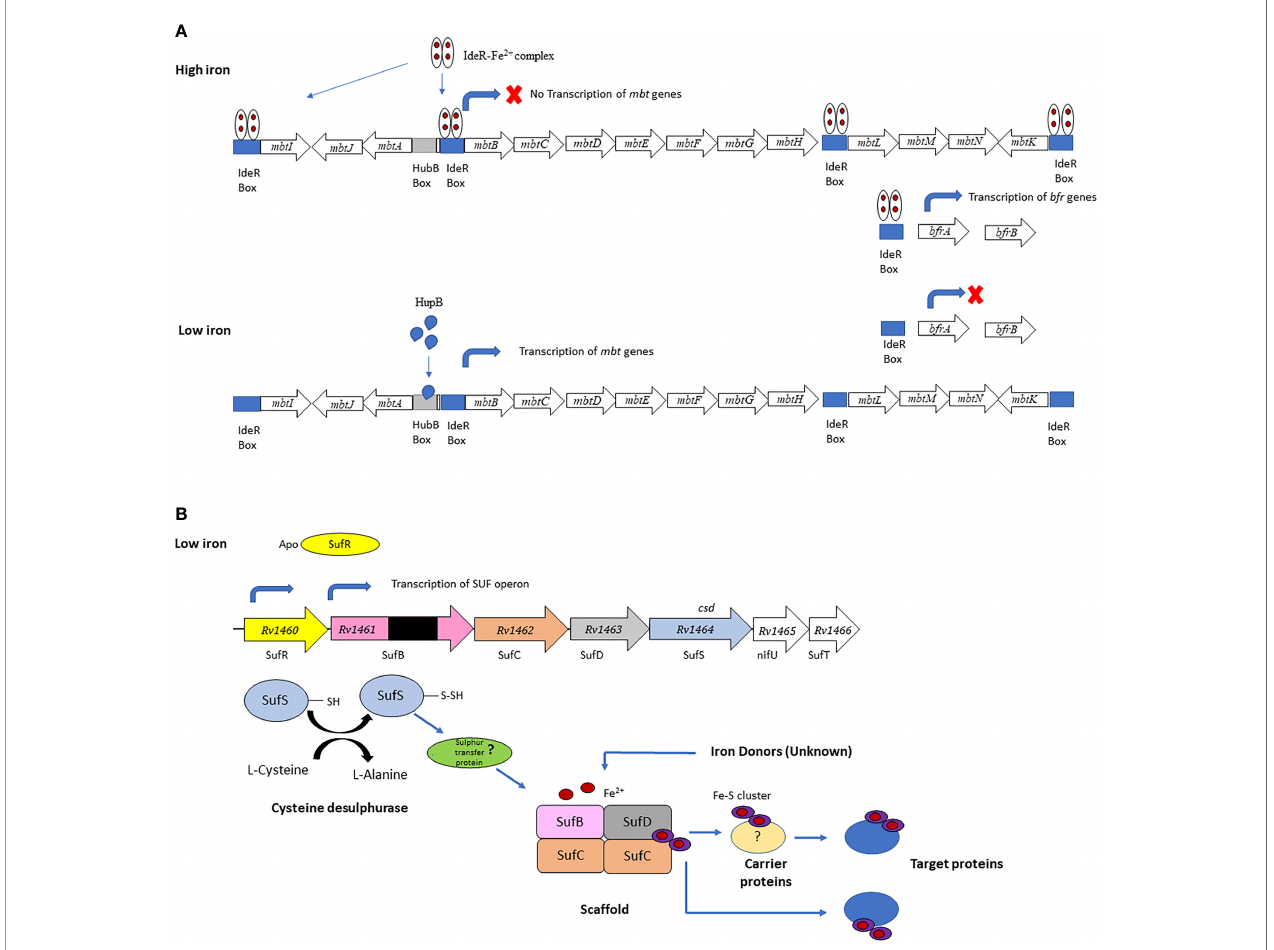
FIGURE 1 | (A) IderR regulates Mtb siderophore biosynthesis and iron storage. The mbtA-J genes synthesize the siderphore core and the mbtL-K genes synthesize the mbtK-acyl complex. Transcription of the siderphore biosynthesis genes is inhibited under iron-suf fi cient conditions and synthesis of the iron storage proteins is activated when the IdeR-Fe 2+ complex binds to the IdeR boxes in the mbt locus and upstream of the bfrA gene. Under iron limiting conditions the IdeR-Fe 2+ complex does not form and does not bind to the IdeR box in the mbtB locus, allowing HupB to bind to the hupB box upstream of the IdeR box activating transcription of the mbt genes. In the absence of the IdeR-Fe 2+ complex transcription of the iron storage genes bfrA and bfrB is repressed. Panel (A) is adapted from Sritharan (12). (B) Fe-S biogenesis machinery in Mtb encoded by a single operon ( sufR-sufB-sufD-sufC-csd-nifU-sufT ). All the genes in the operon, except for sufR , were predicted to be essential by forward genetic screens. This fi gure is adapted from Willemse